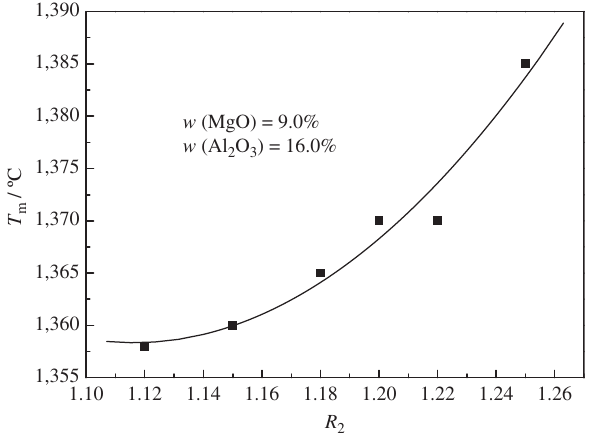
Figure 11: Effect of R 2 on T m of slag.